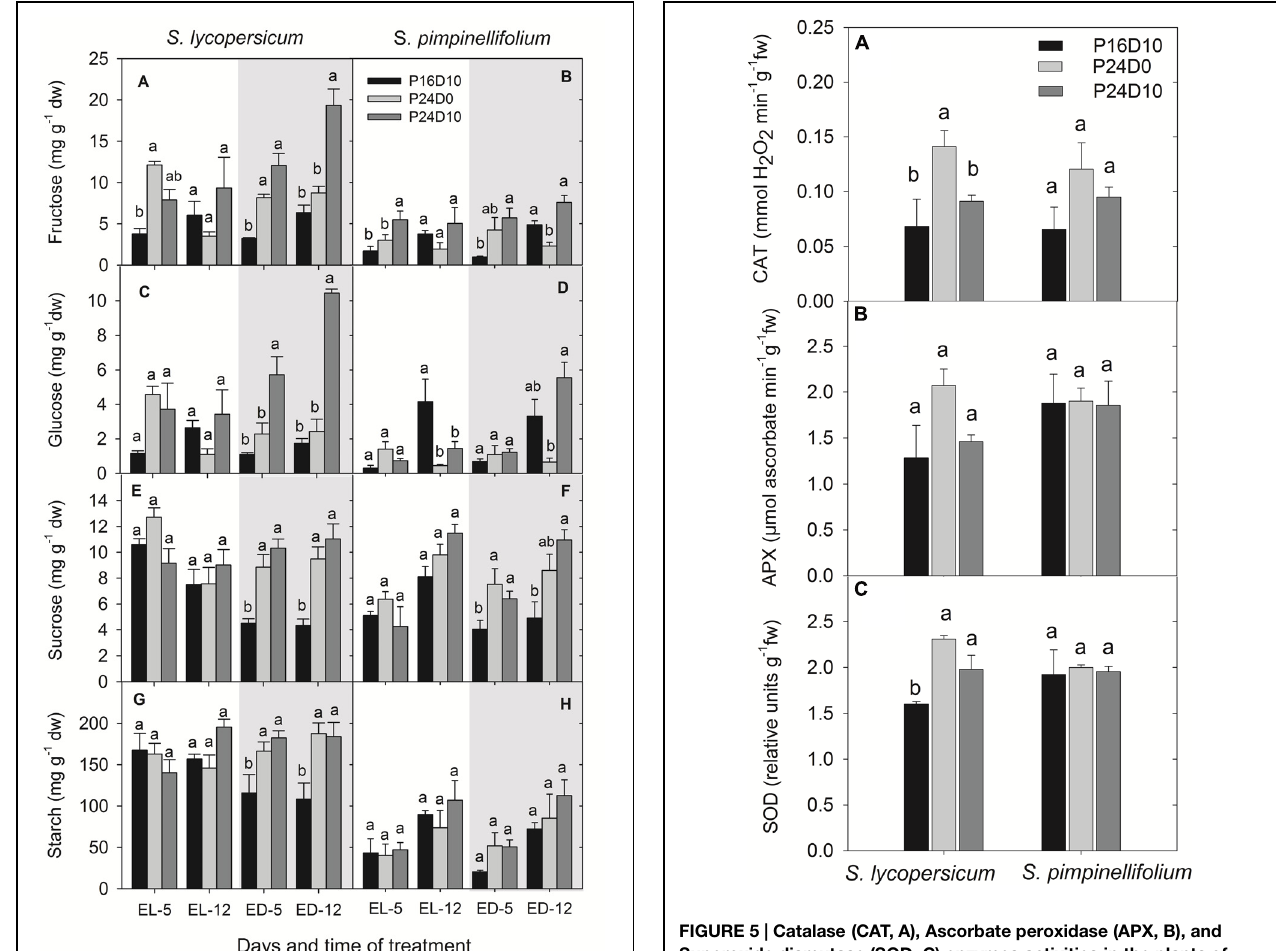
( Figure 6B ). In S. lycopersicum , both leaf and stem DW